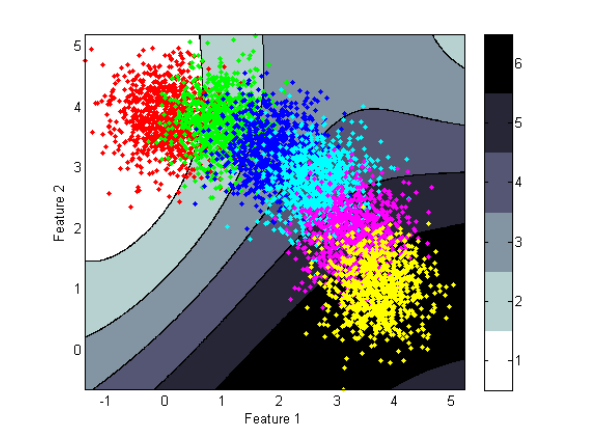
Figure 6: Decision boundaries of the Support Vector Regression model at the simulated data set. The continuous predictions are rounded to an integer to extract the decision boundaries.